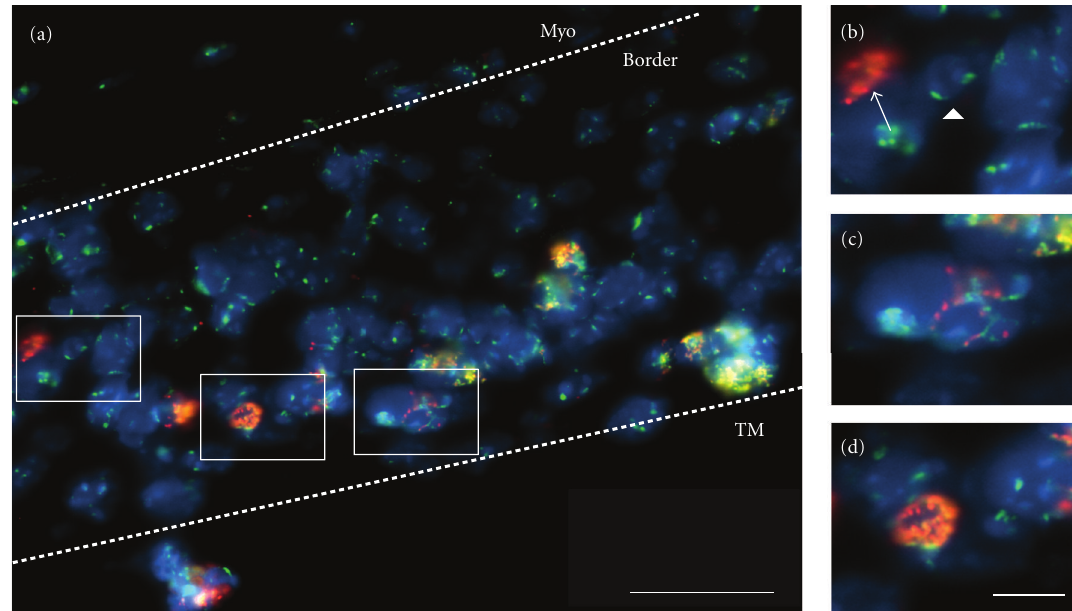
Figure 4: Fusion of VSV-G-expressing human mesenchymal stem cells (donor) with cardiomyocytes (host) in vivo . (a) Fluorescence in situ hybridization with species-specific centromeric probes to detect fusion products in the murine myocardium. Human MSCs (red), mouse cells (green), all nuclei (blue), and fusion products (FP; red and green signal in the same nucleus) are found within the border and TM regions, while typically only mouse cells are found in the myocardium, “myo.” Insets display (b) human (arrow) and mouse (arrowhead) cells, (c) representative fusion product, and (d) fusion product undergoing anaphase, indicative of